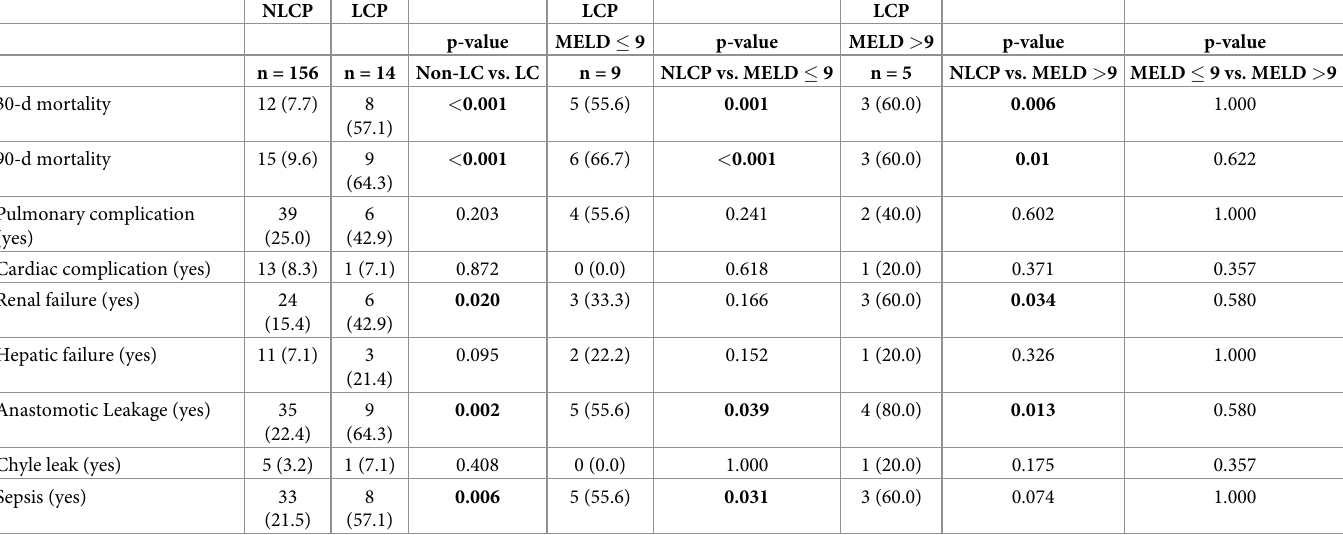
(p = 0.035, Table 3) and 30-day and 90-day mortality rates (p < 0.001). Renal failure (p = 0.020), anastomotic leakages (p = 0.002), and sepsis (p = 0.006) were significantly more frequent in LCP, whereas pulmonary complications (p = 0.854) and hepatic failure (p = 0.095) were equally distributed in both groups. Of 13 LCP with severe complications Clavien Dindo � 3, 8 (61.5%) underwent surgical revision. groups showed comparable results in contrast to NLCP, especially in terms of mortality. While sepsis and renal failure revealed only significant differences between NLCP and the High- MELD group, sepsis only differed significantly between NLCP and the Low-MELD group. with no significant difference. After adjustment for gender, age, surgical approach and comor- bidity index, LCP demonstrated 10.5 times higher odds for 30-day ([95%CI 2.704–40.763], p = 0.001; Table 4) and 16.5 times higher odds for 90-day mortality ([95%CI 3.873–70.014], p < 0.001) compared to NLCP. Moreover, increased risks for renal failure (p = 0.010), anasto- motic leakage (p = 0.020), and sepsis (p = 0.015) are shown for cirrhotic patients. Prediction of mortality depicted in Table 5. Univariate analysis revealed significant differences for tumor stages (p = 0.036), presence of preoperative ascites (p = 0.031, p = 0.038) and portal hypertension (p = 0.031, p = 0.038). MELD and Child Score just as their categories failed to predict 30-day or 90-day mortality. Hence, several components of these scores correlated significantly with mortality, such as bilirubin (p = 0.018, p = 0.001) and INR (p = 0.009, p = 0.002), and also platelet count (p = 0.002, p = 0.003) demonstrated statistical significance. Moreover, the occur- rence of specific complications was not associated with mortality. Table 3. Unadjusted analysis of postoperative outcomes by severity of liver cirrhosis. NLCP LCP LCP LCP p-value MELD � 9 p-value MELD > 9 p-value p-value n = 14 Non-LC vs. LC n = 9 NLCP vs. MELD �